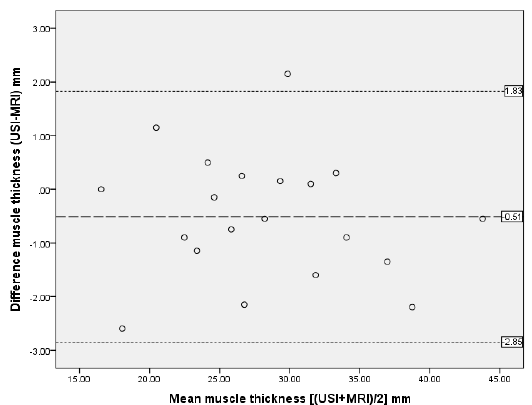
Figure 5. Bland and Altman plot showing difference between measurements of muscle thickness from MRI and US scan. The dashed line represents the mean difference; dotted lines are 95% upper and lower limits of agreement, representing two standard deviations.